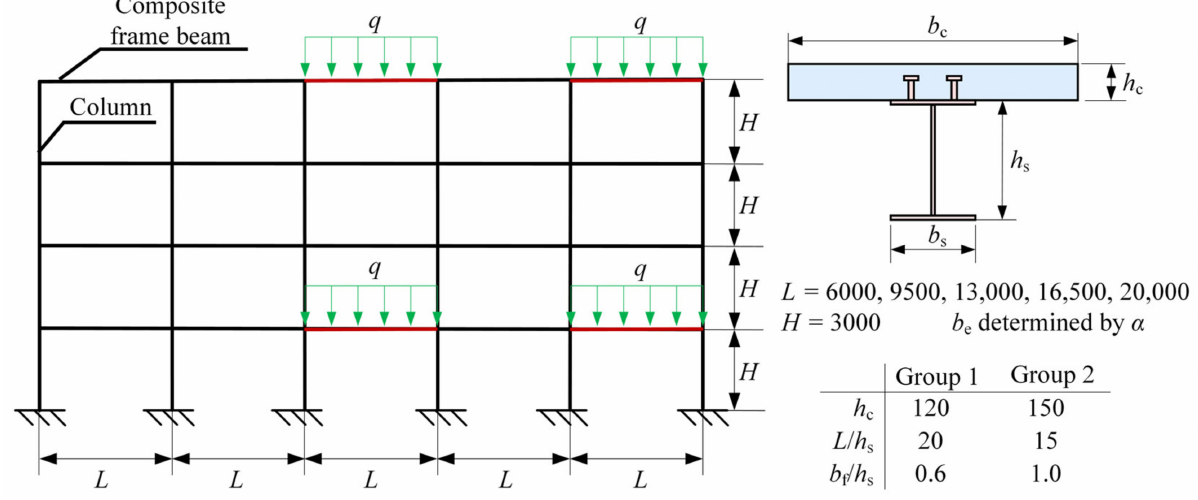
Figure 10. Finite element model of the composite frame example.